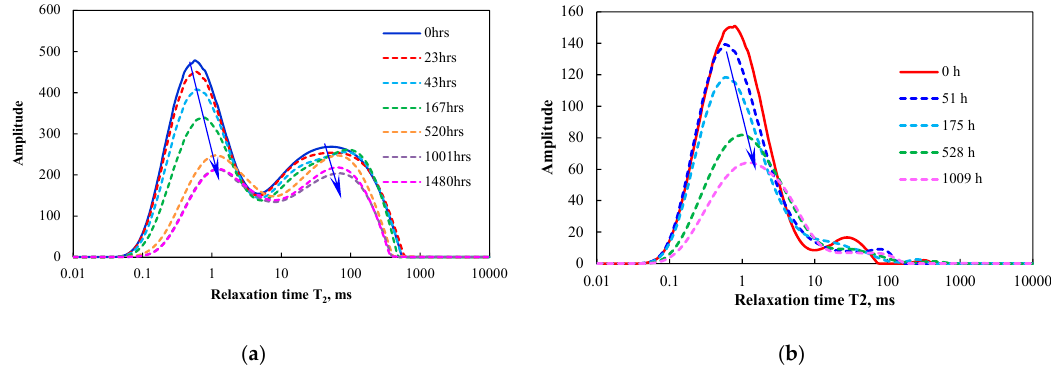
Figure 4. The T 2 spectra vs soaking time in UC7-1 and LC7-1 samples: ( a ) UC7-1 and ( b ) LC7-1. Figure 3. The small oil droplet displaced by water in UC7-1 samples.